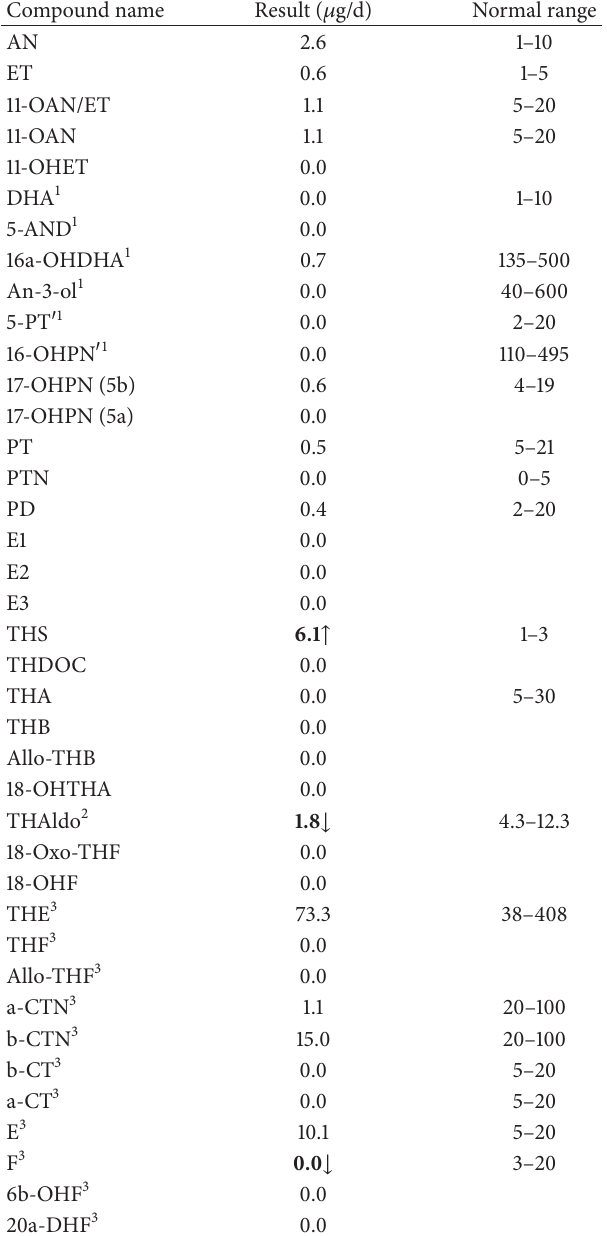
Table 1: The patient’s urinary steroid profile by gas chromatogra- phy/mass spectrometry (GC/MS) (values 0.0 < the sensitivity of the